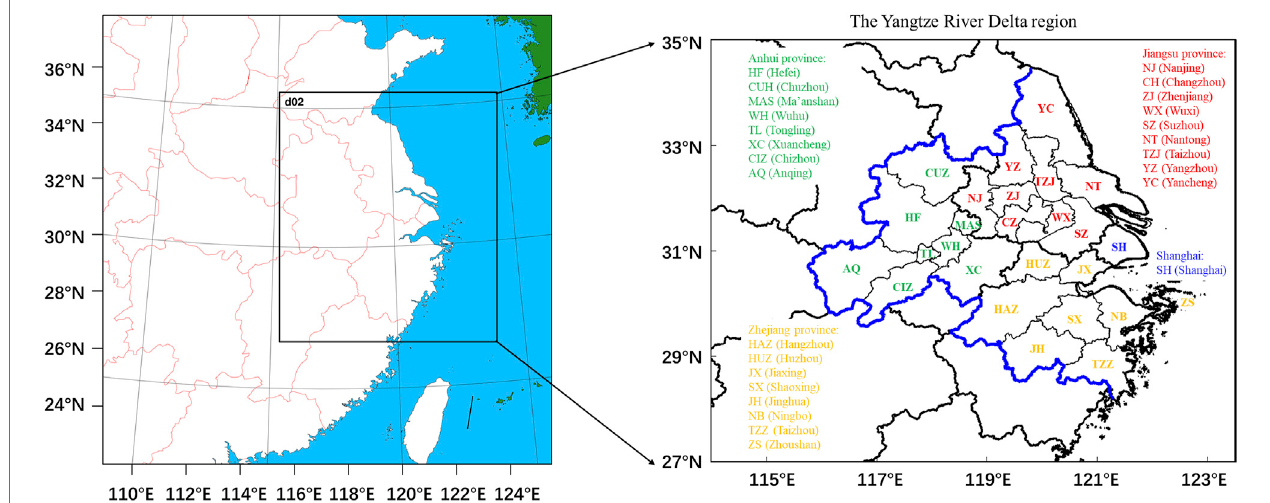
FIGURE 1 | Simulation domains of the WRF-Chem model used in this study (left). Right panel illustrates the YRD region as well as the locations of 26 cities in the YRD region. Names of the 26 cities are also labeled with colorful text in this panel.